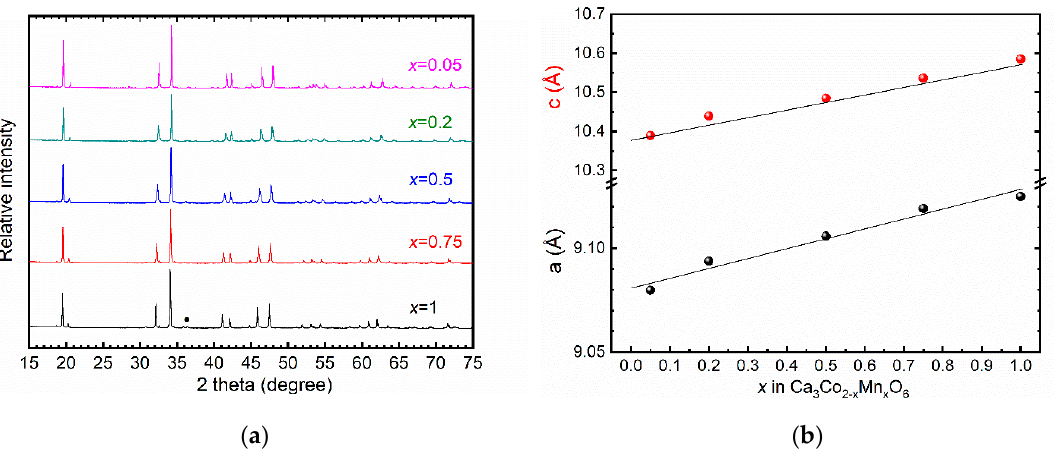
Figure 1. ( a ) XRD patterns of Ca 3 Co 2 − x Mn x O 6 ( x = 0.05, 0.2, 0.5, 0.75, and 1) with marked Mn 2 O 3 peak